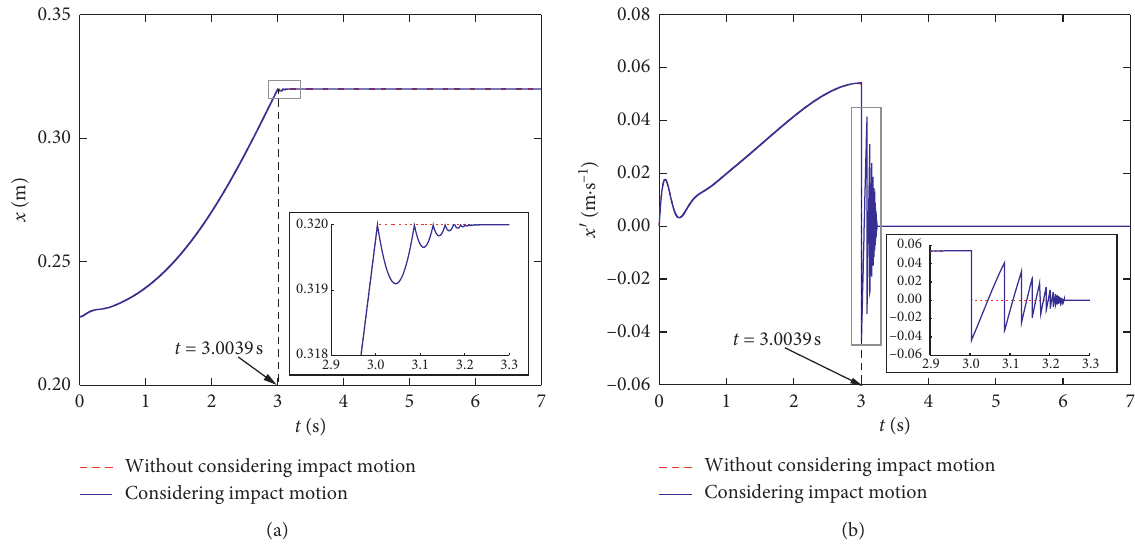
Figure 13: (a) Position variation of the slider. (b) Velocity variation of the slider.